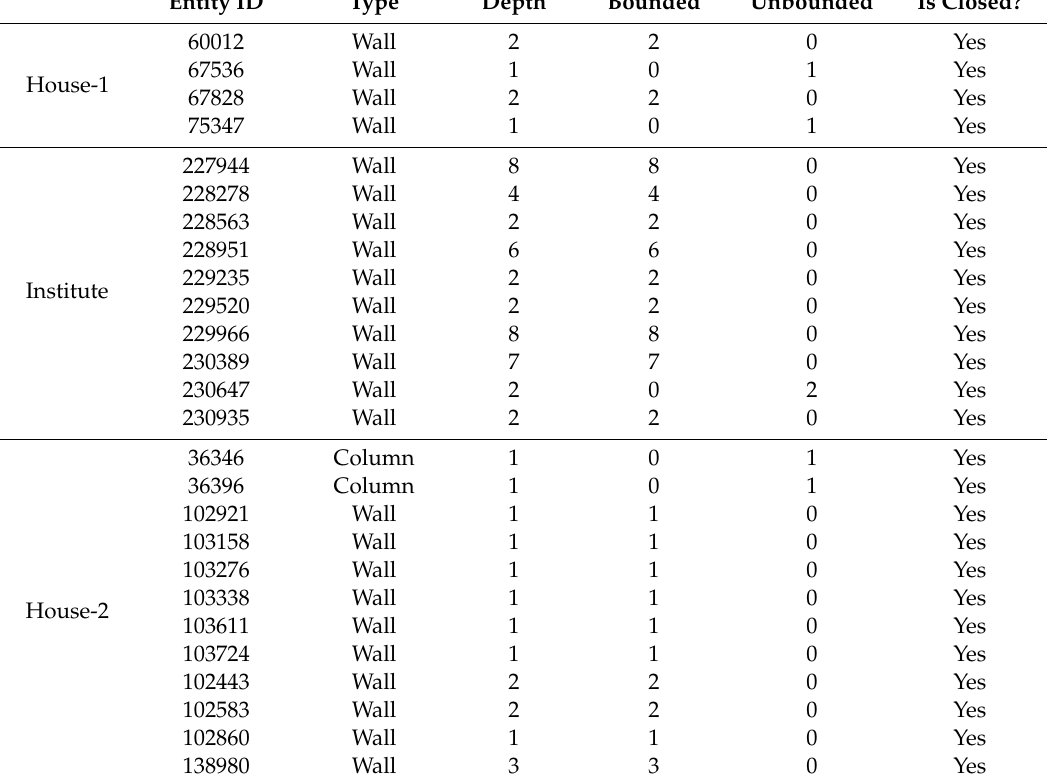
Table 5. Details about building components originally represented by clipping, including entity ID, type of element (Type), clipping depth (Depth), quantity of bounded half space (Bounded), quantity of unbounded half space (Unbounded), and if the generated B-Rep representation is closed (Is closed).